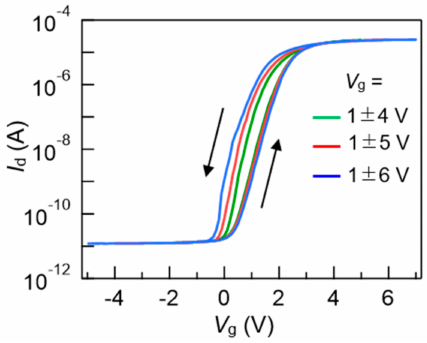
Figure 4. Static static drain current versus gate voltage ( I d – V g ) curves of a FeFET with L ch = 85 nm. The channel width was W = 150 µ m. V g ranges were V g = 1 ± 4 V, 1 ± 5 V and 1 ± 6